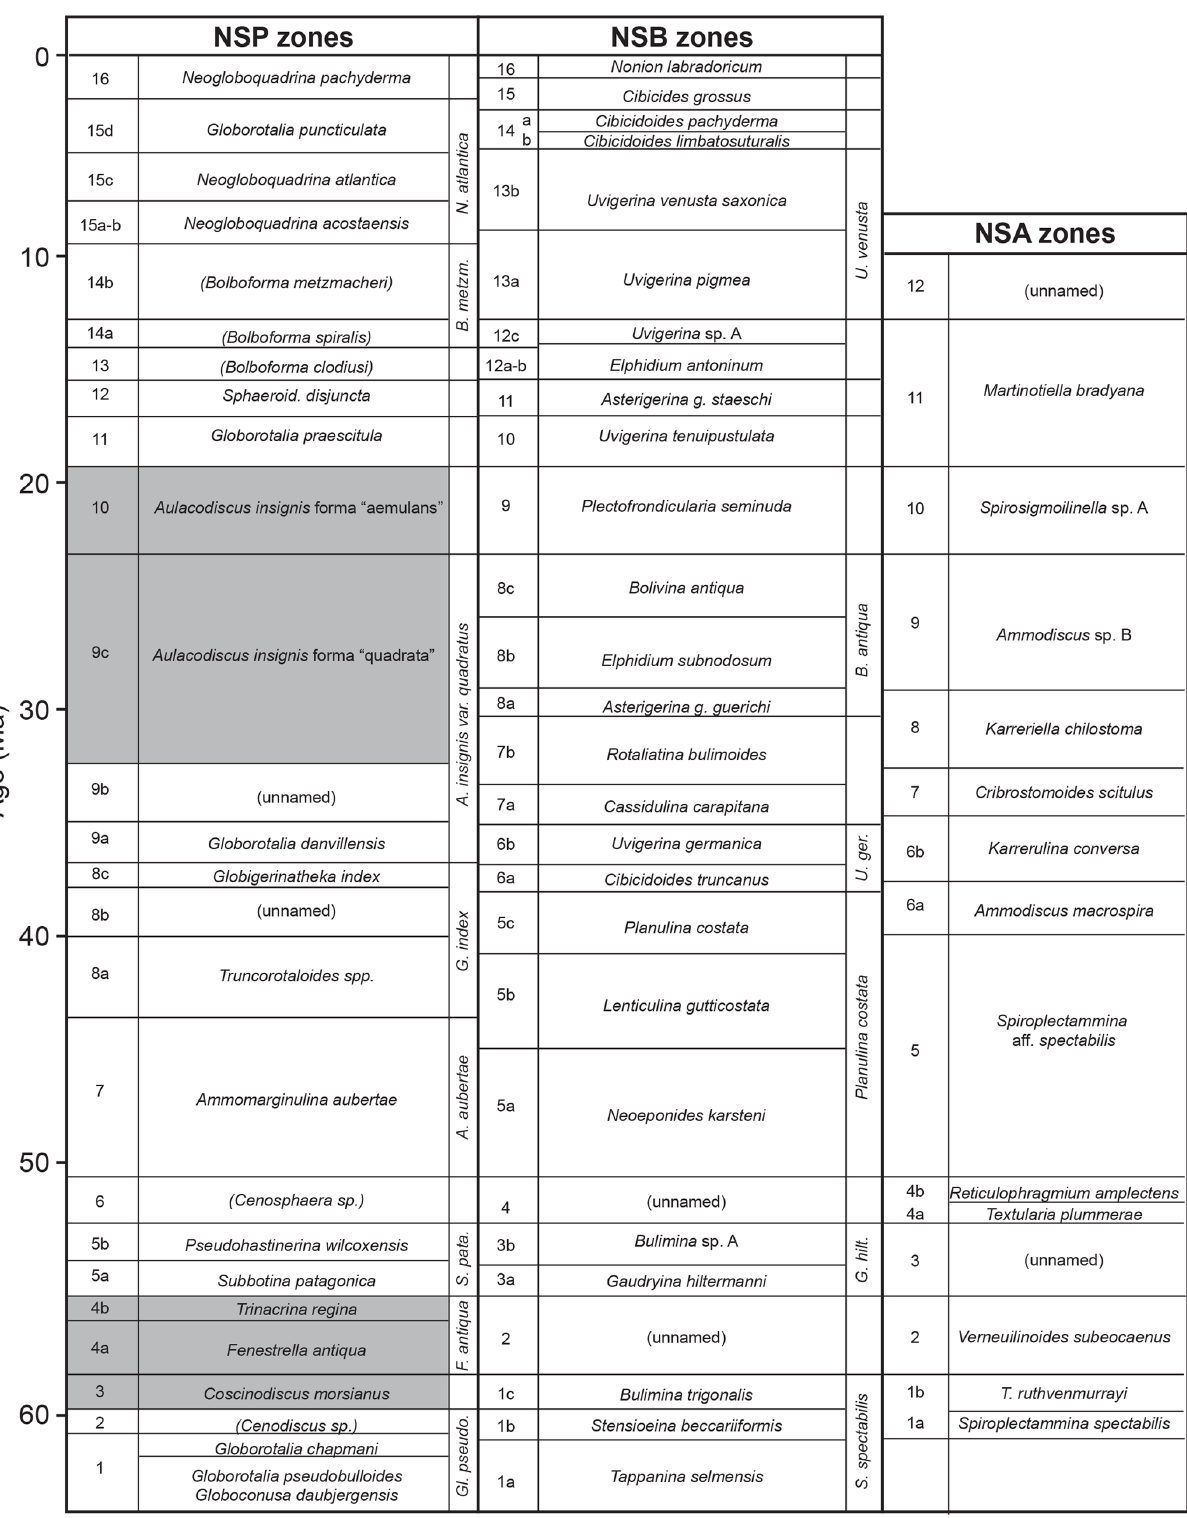
Figure 2. North Sea micropalaeontological zonation including diatoms (after King 1989).